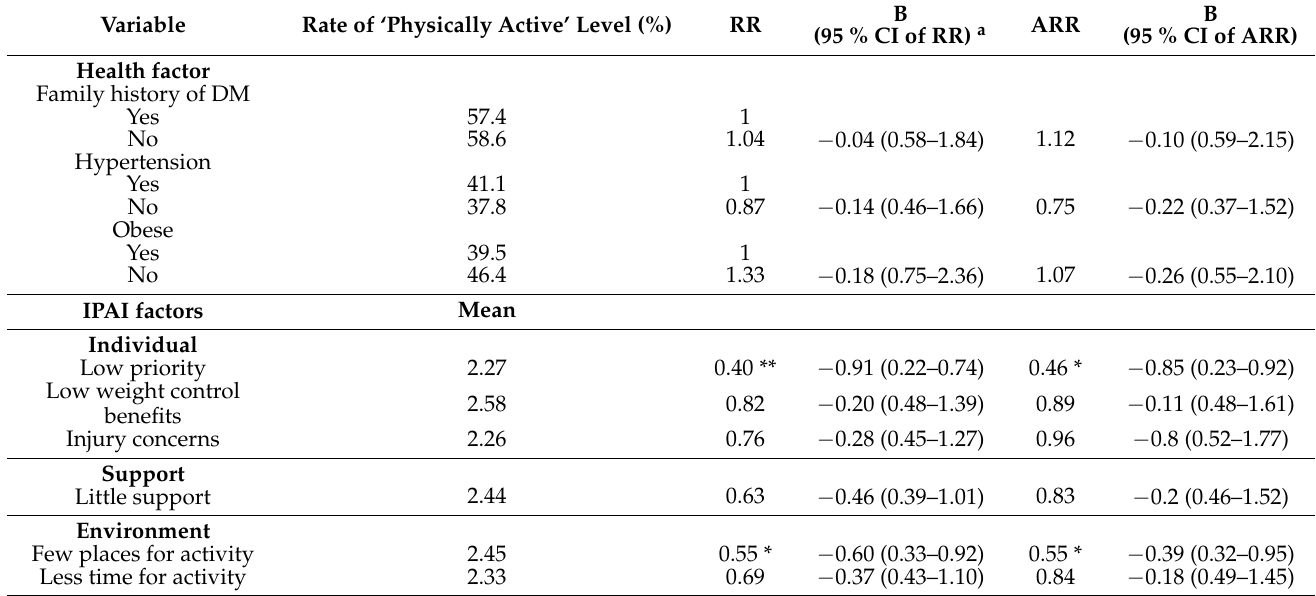
A logistic regression analysis using the forward method indicated that men were more likely to engage in physical activity than women (adjusted RR= 2.11; 95% CI = 1.34–3.31; p = 0.002). The participants who gave physical activity a lower priority (adjusted RR= 0.44; 95% CI = 0.24–0.81; p = 0.013) and had less access to places for physical activity (adjusted RR= 0.55; 95% CI = 0.32–0.95; p = 0.045) were less likely to be active. The three variables accurately predicted 63.2% of the physical activity behaviours of the 342 participants at risk of diabetes (Table